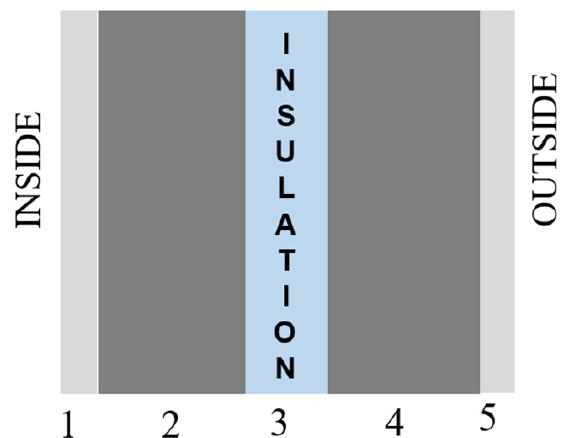
Figure 3. External wall configuration—50 mm insulation (3) sandwiched by 100 mm lightweight concrete block (2 and 4) and 10 mm cement plaster (1 and 5). Table 2. Type of thermal insulation with abbreviation.